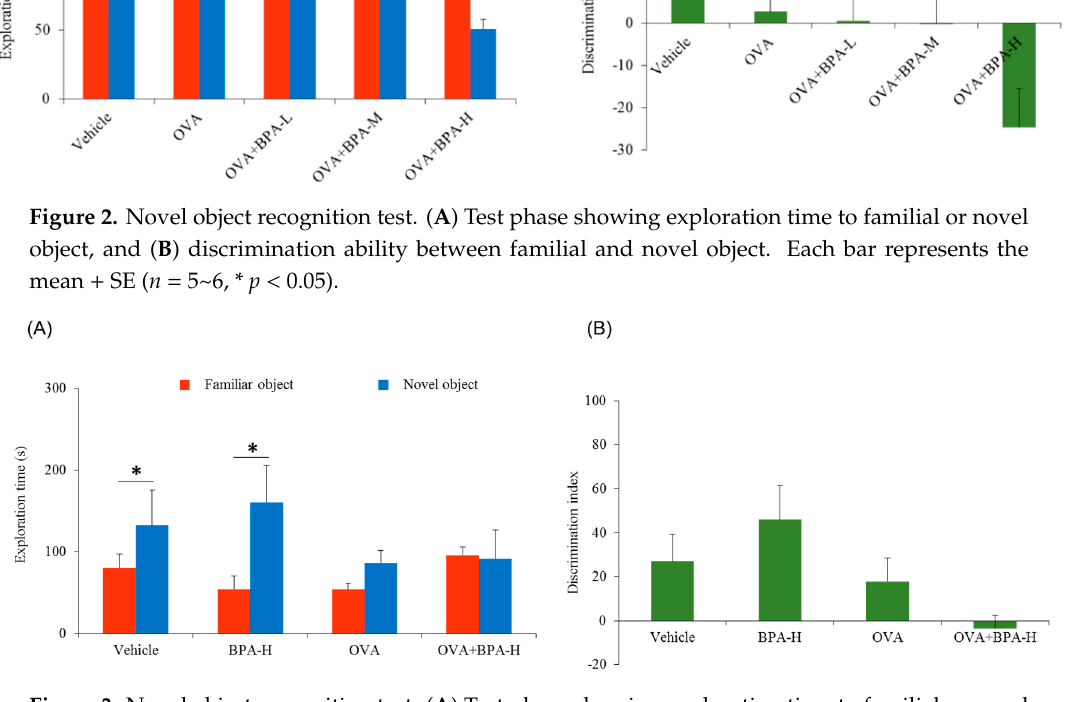
Figure 3. Novel object recognition test. ( A ) Test phase showing exploration time to familial or novel object, and ( B ) discrimination ability between familial and novel object of BPA-H exposed mice with or without ovalbumin (OVA). Each bar represents the mean + SE ( n = 5~6, * p < 0.05).